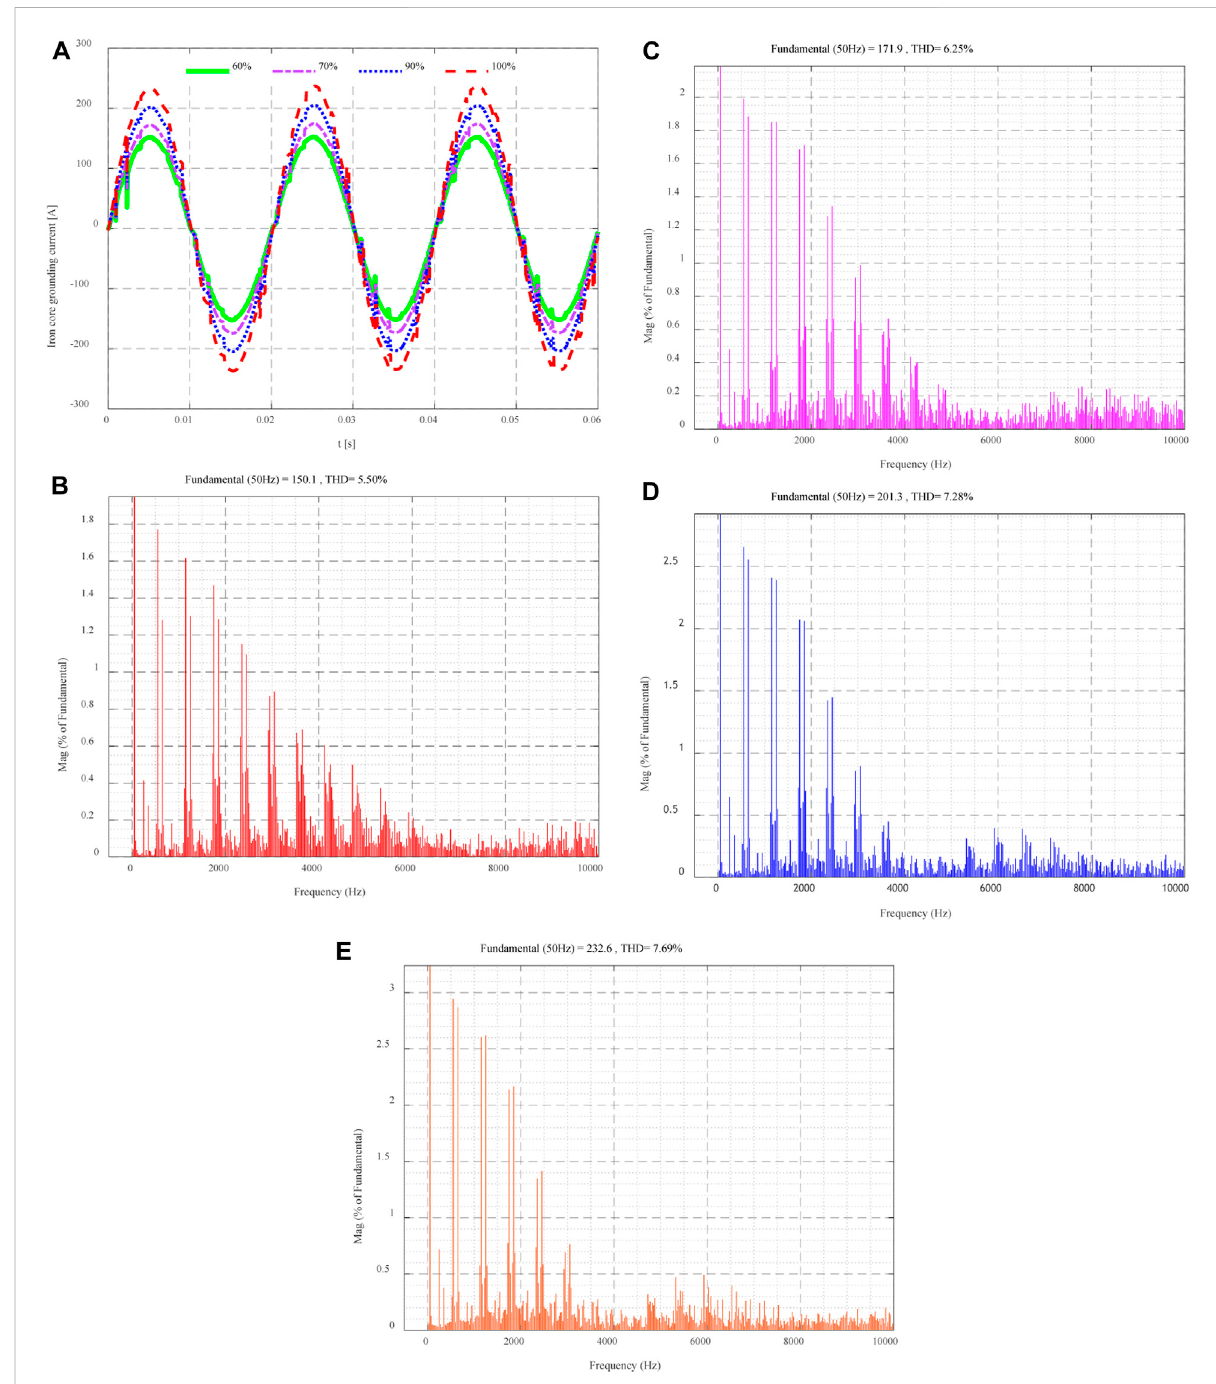
FIGURE 9 Waveform and spectrum analysis of single point grounding current of converter transformer under different loads: (A) Grounding current; (B) Current spectrum at 60% load; (C) Current spectrum at 70% load; (D) Current spectrum at 90% load; (E) Current spectrum at 100% load.